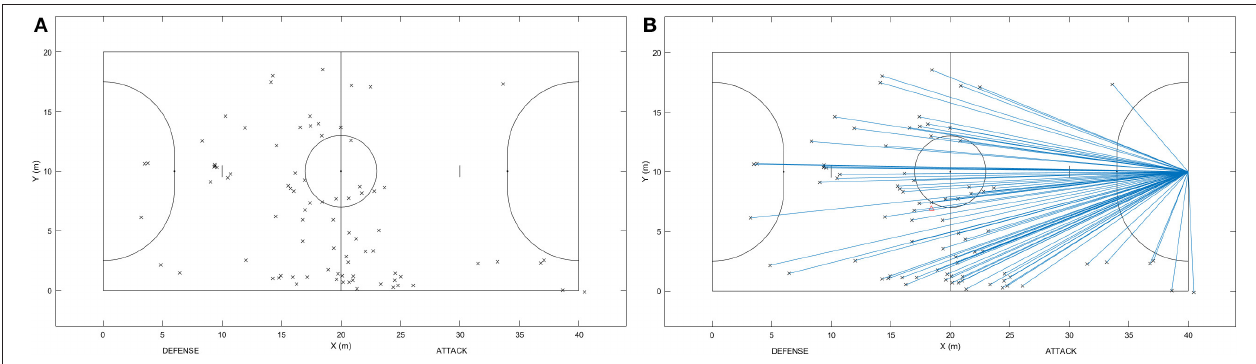
FIGURE 1 | Example of (A) technical actions of players recorded across the court (“x” symbol represents the estimated location where a given category of technical actions occurred [e.g., accurate passing with dominant limb]—see Data acquisition and coding for more information) and (B) illustration of lines drawn connecting location where each of technical actions occurred to the midpoint of the opposition goal line, used to measure the Euclidean distance between